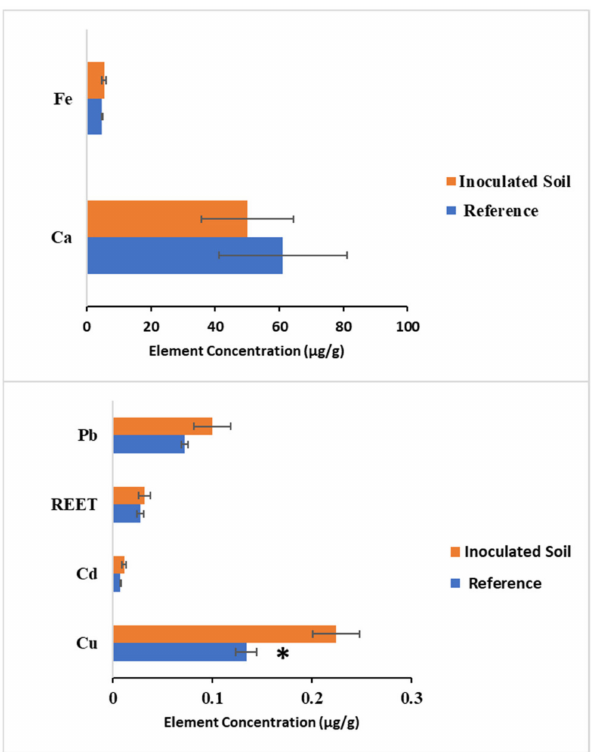
Figure 1. Incubation experiment: effect of soil inoculation on element concentration in aqueous extract per dry weight of soil. Significant difference ( p ≤ 0.05) between means indicated by asterisks * (mean ± SE, n =